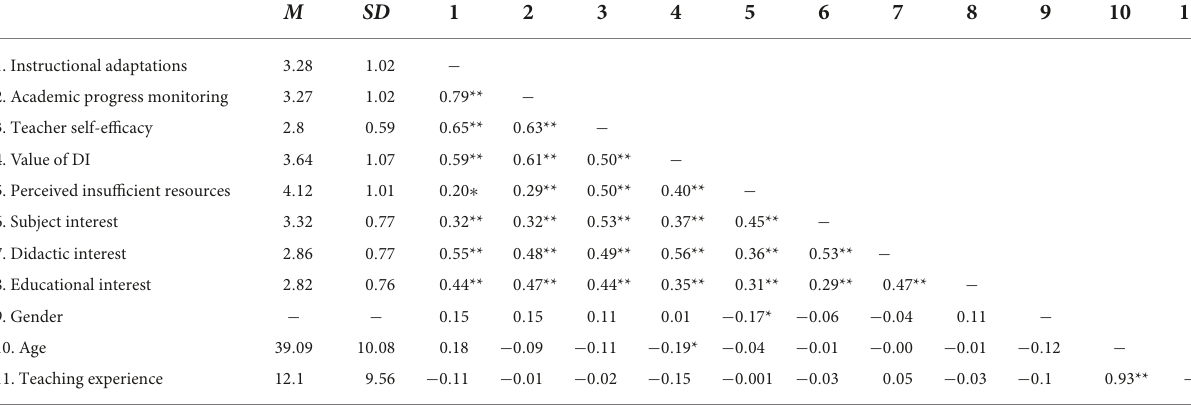
TABLE 1 Means, standard deviations, and correlations of all variables.